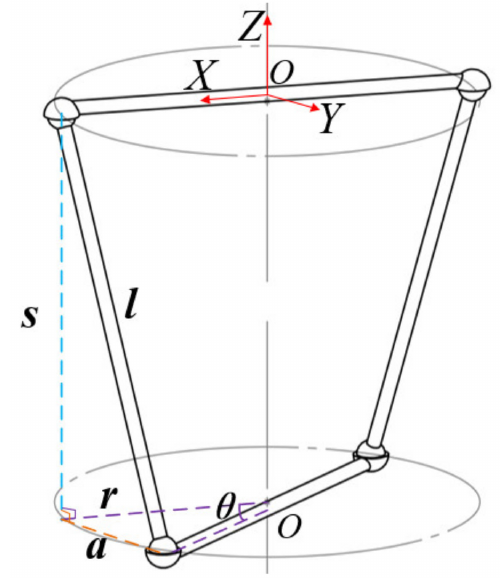
Figure 2. Double-linkage mechanism space geometry relationship diagram. The projection of the connecting rod in the XOY plane can be decomposed along the X and Y axes, as shown in Figure